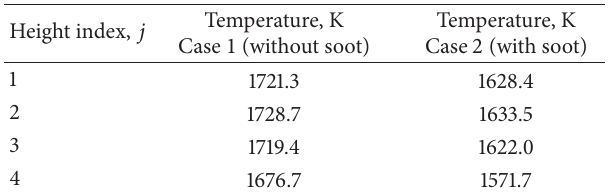
Table 4: Temperature distribution in furnace with and without soot effect, 𝑖 = 2 and 𝑗 = 1, 2, .. ., 4 .